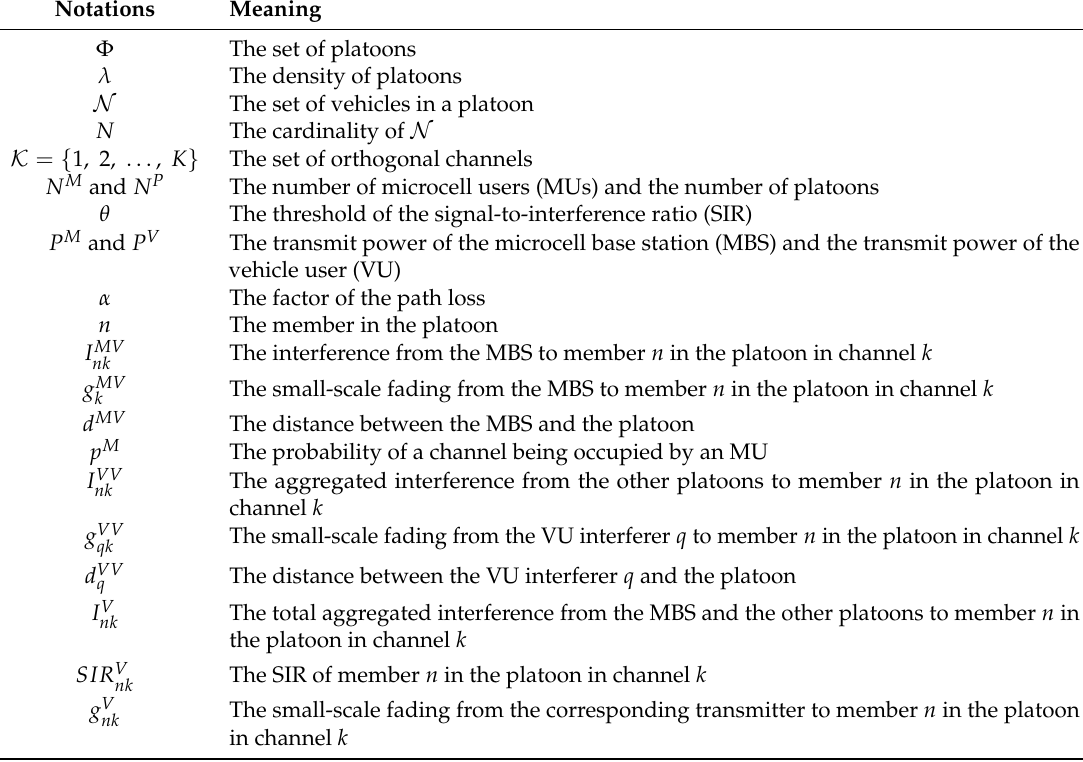
Table 1. Summary of